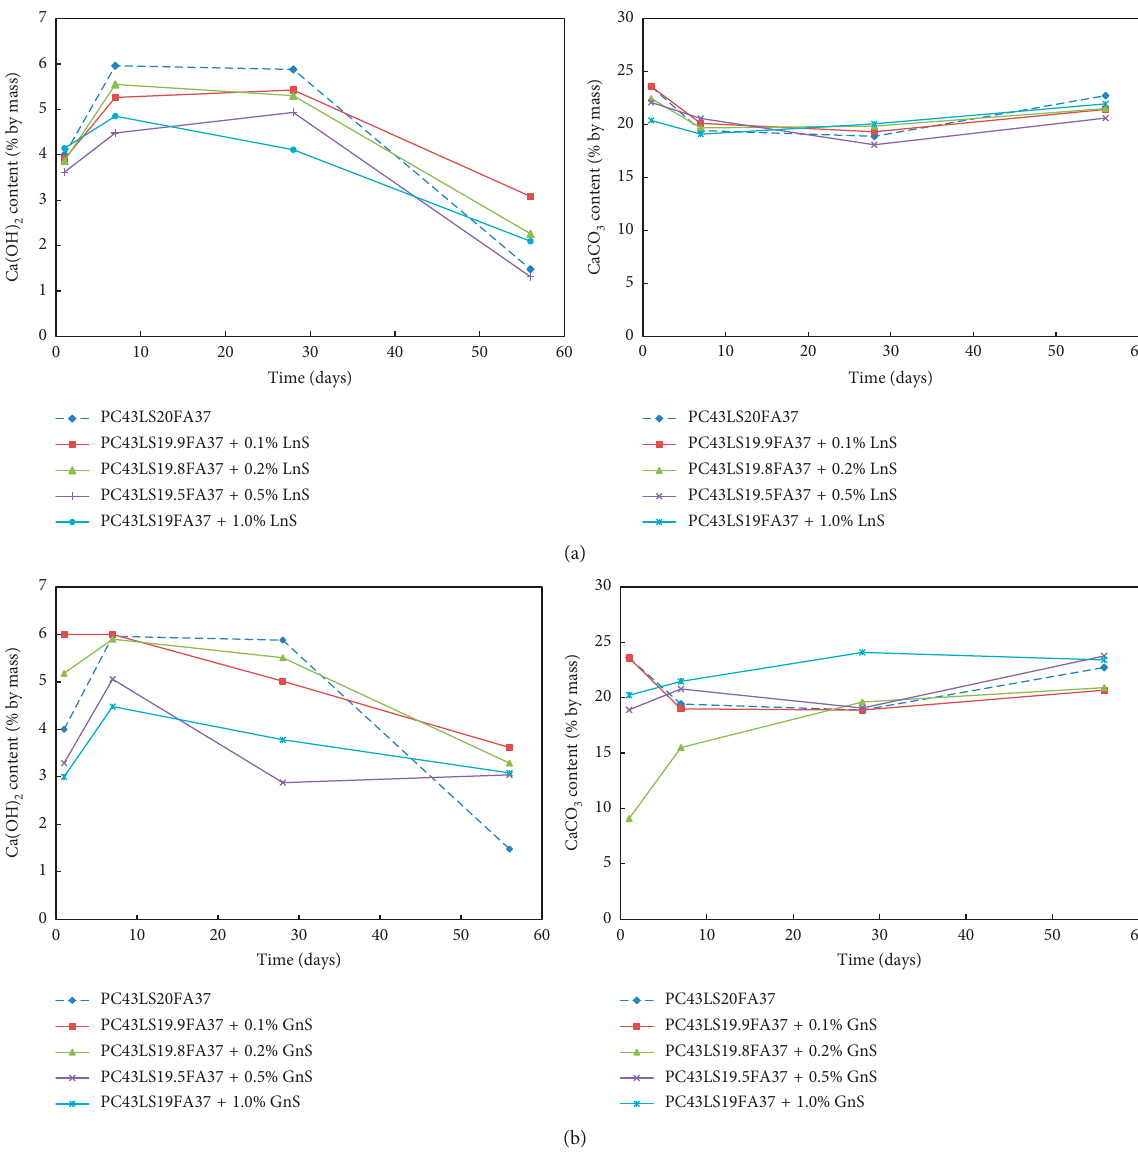
Figure 10: Ca(OH) 2 and CaCO 3 content of (a) LnS and (b) GnS nanocomposite binders based on